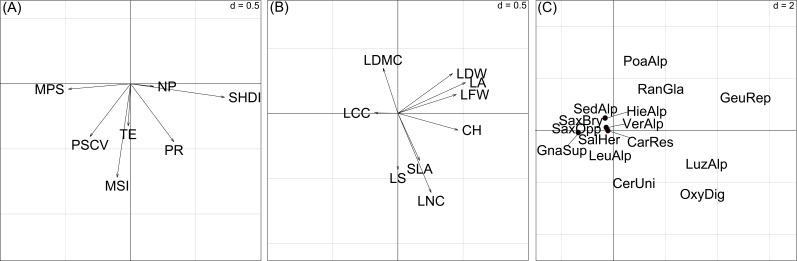
Ordination diagrams of the first two axes of the RLQ-analysis displaying the (A) landscape metrics scores, (B) plant trait scores, (C) species scores.Abbreviations for landscape metrics and plant traits are reported in Table 1. Abbreviations for species: CarRes, Cardamine resedifolia; CerUni, Cerastium uniflorum; GeuRep, Geum reptans; GnaSup, Gnaphalium supinum; HieAlp, Hieracium alpinum; LeuAlp, Leucanthemopsis alpina; LuzAlp, Luzula alpino-pilosa; OxyDig, Oxyria digyna; PoaAlp, Poa alpina; RanGla, Ranunculus glacialis; SalHer, Salix herbacea; SaxBry, Saxifraga bryoides; SaxOpp, Saxifraga oppositifolia; SedAlp, Sedum alpestre; VerAlp, Veronica alpina. Adenostyles leucophylla was not reported to avoid excessive gathering of points; its position is approximately (20, 5). The values of d give the grid size.